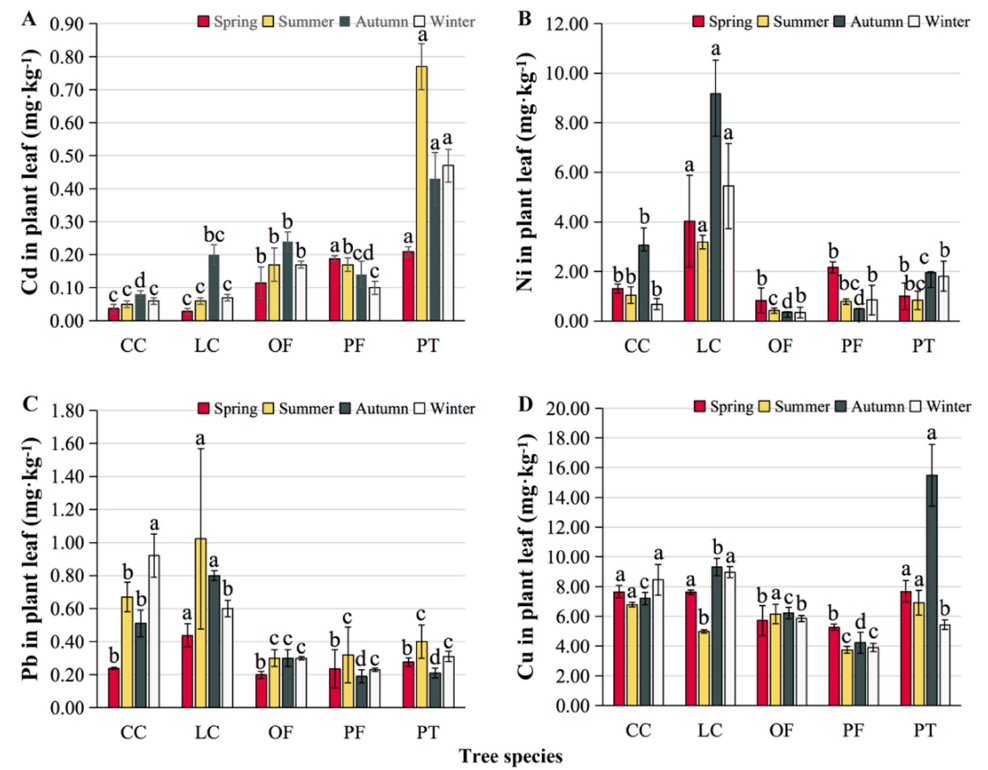
Figure 4. Metal content in leaves of different plants. Note: A: spring, B: summer, C: autumn, D; winter; CC: Cinnamomum camphora (L.) Presl; LC: Loropetalum chinense var. rubrum Yieh; OF: Osmanthus fragrans (Thunb.) Loureiro; PF: Photinia×fraseri Dress ; PT: Pittosporum tobira (Thunb.) Ait . Different lowercase letters indicate the significant differences among different plant species in the same season ( p < 0.05).